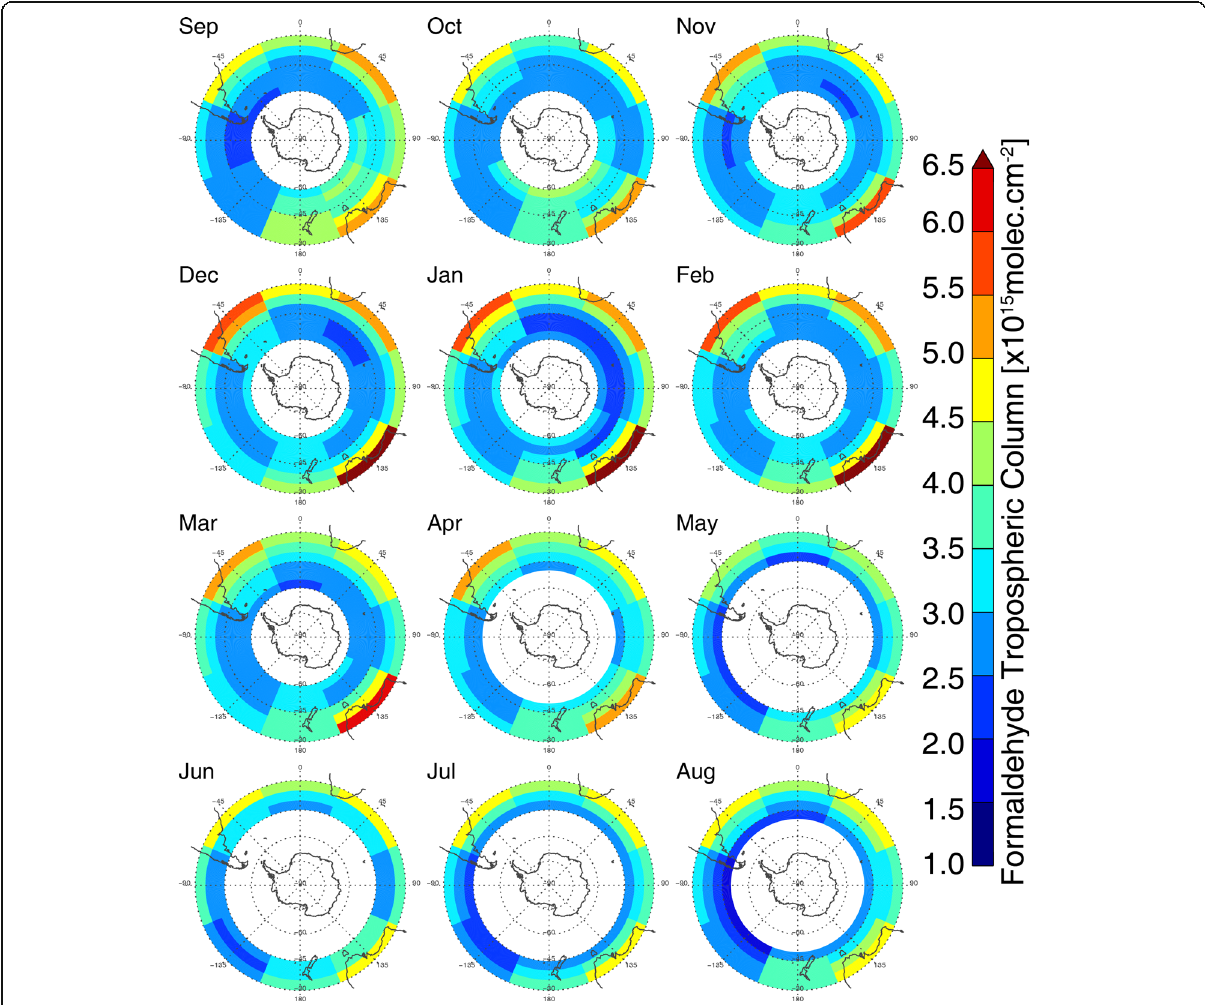
Fig. 4 Climatological monthly mean distribution of the OMI formaldehyde (HCHO) tropospheric column (×10 15 molecule cm − 2 ) at 30 – 60° S. The color in each pixel reveals the median HCHO value for all available measurements from 2005 to